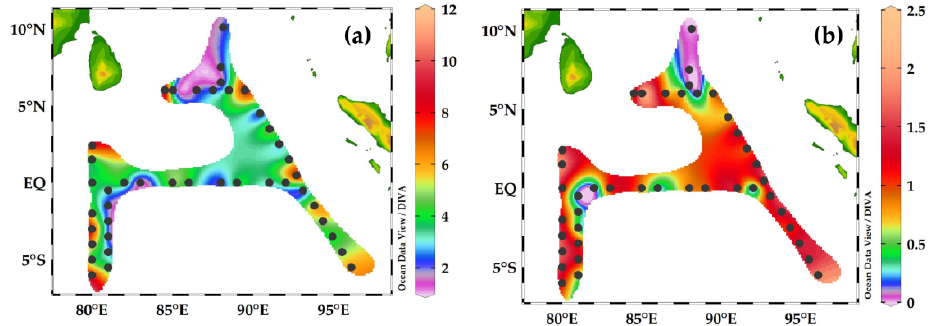
Figure 5. Species richness ( a ) and Shannon diversity H’ ( b ) of foraminifera in the Eastern Indian. Ocean. ( a ) The distribution of species per sample indicates the high species numbers that occurred in the south-equatorial zone (SEQ) at transect 80° E and low species number/station in the Bay of Bengal (BoB) station at the transect 90° E. ( b ) Diversity of foraminifera is higher in all transects except for a few stations of BoB.